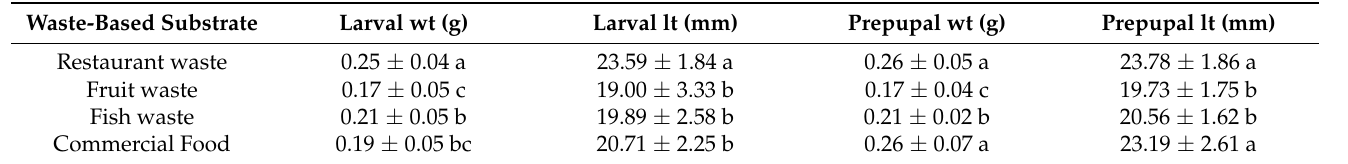
Table 3. Larval and pre-pupal length and weights of BSFs reared under different waste-based substrates.